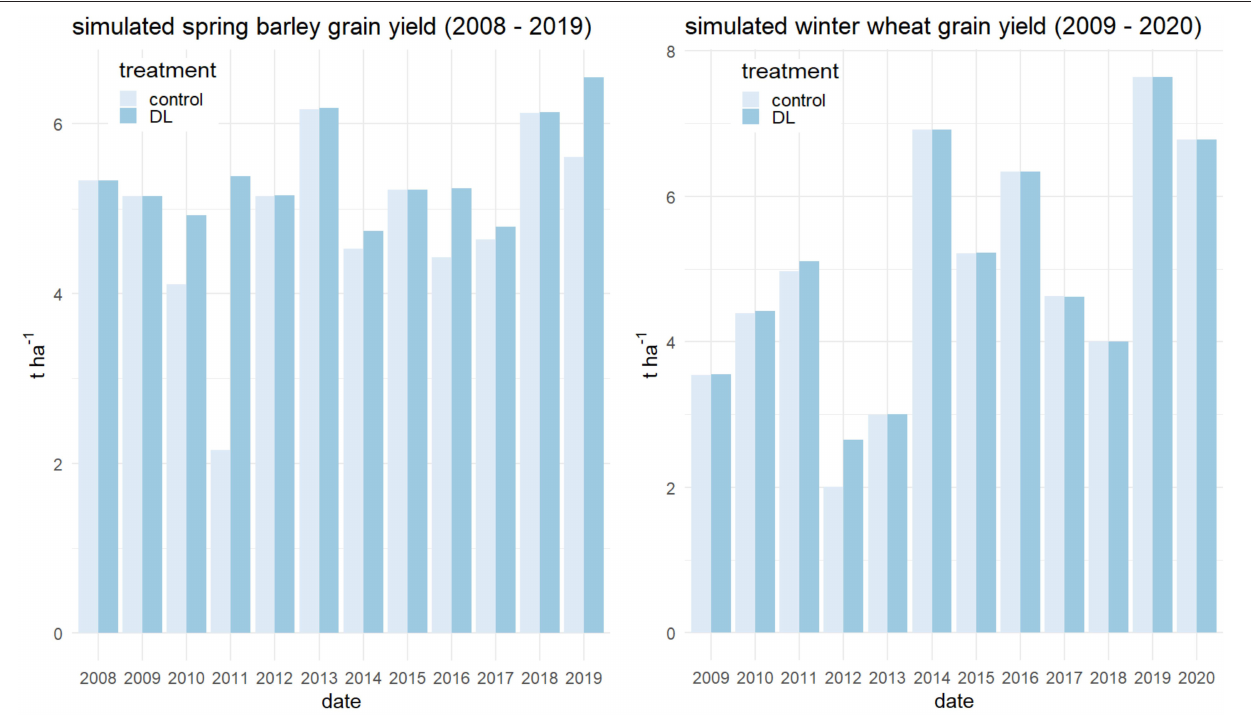
FIGURE 3 | Simulated spring barley (left) and winter wheat (right) grain yield in t ha − 1 for the harvesting years 2008 to 2020 at the CKA Research Station, Germany using the coupled SIMPLACE-cRootbox